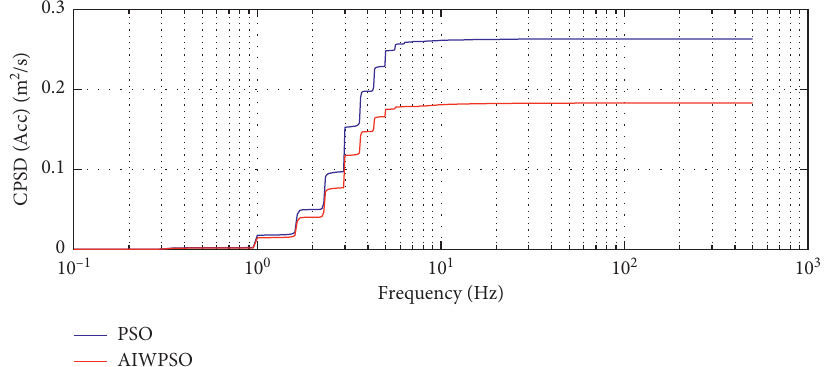
Figure 19: CPSD of acceleration for a trapezoidal